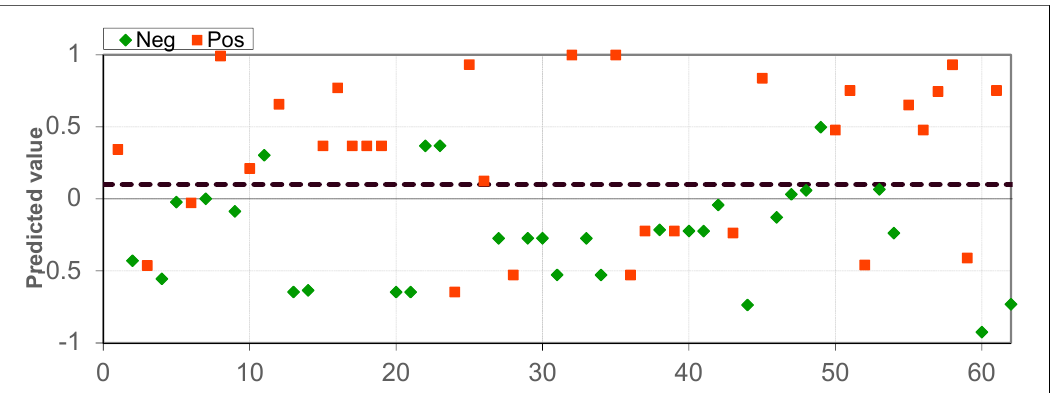
Figure 6. Scatter plot for healthy patients and patients with laryngeal or oropharyngeal cancer.